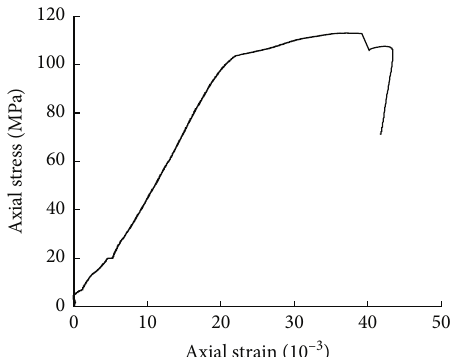
Figure 8: Axial stress-strain curves of sandstone under conventional triaxial loading at 20 MPa confining